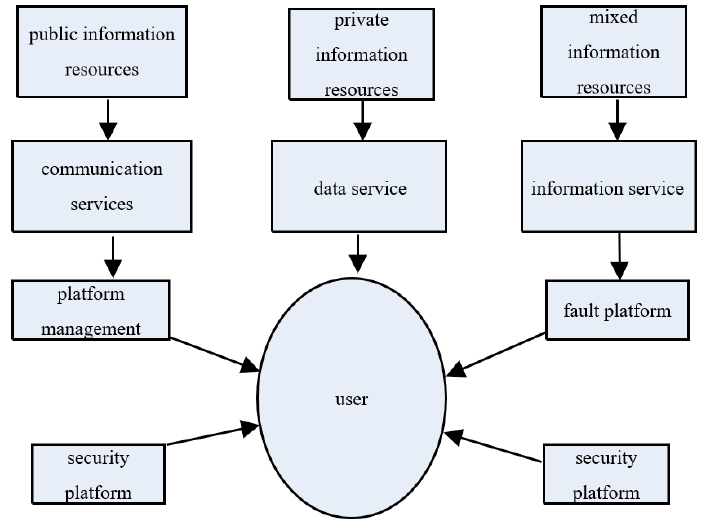
Figure 2. SPI resource structural